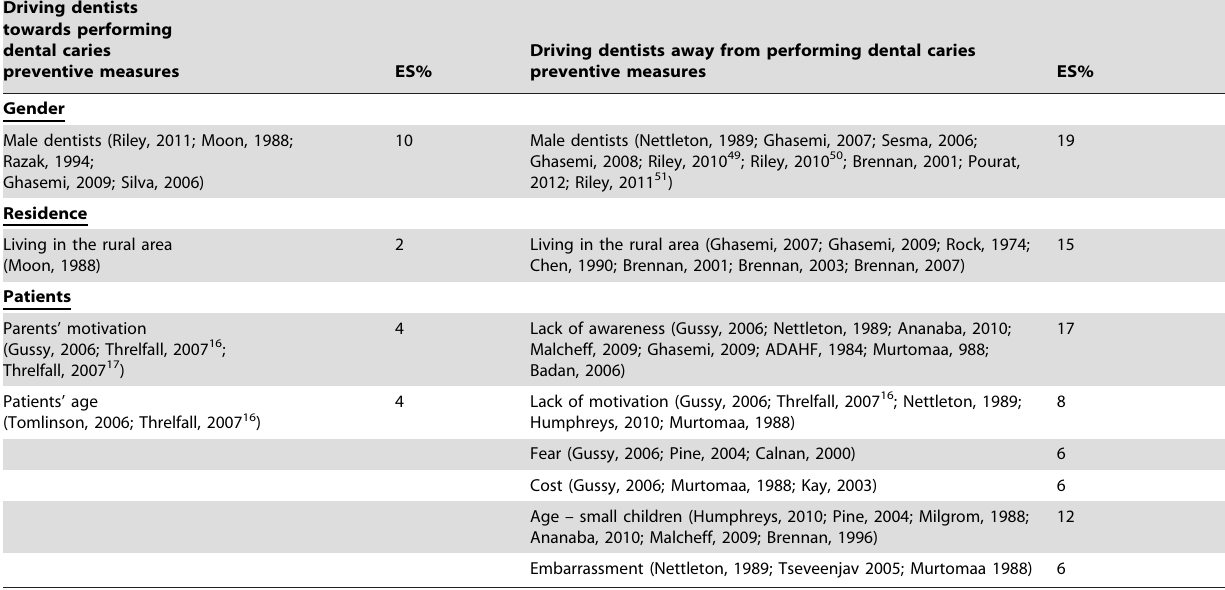
Driving dentists towards